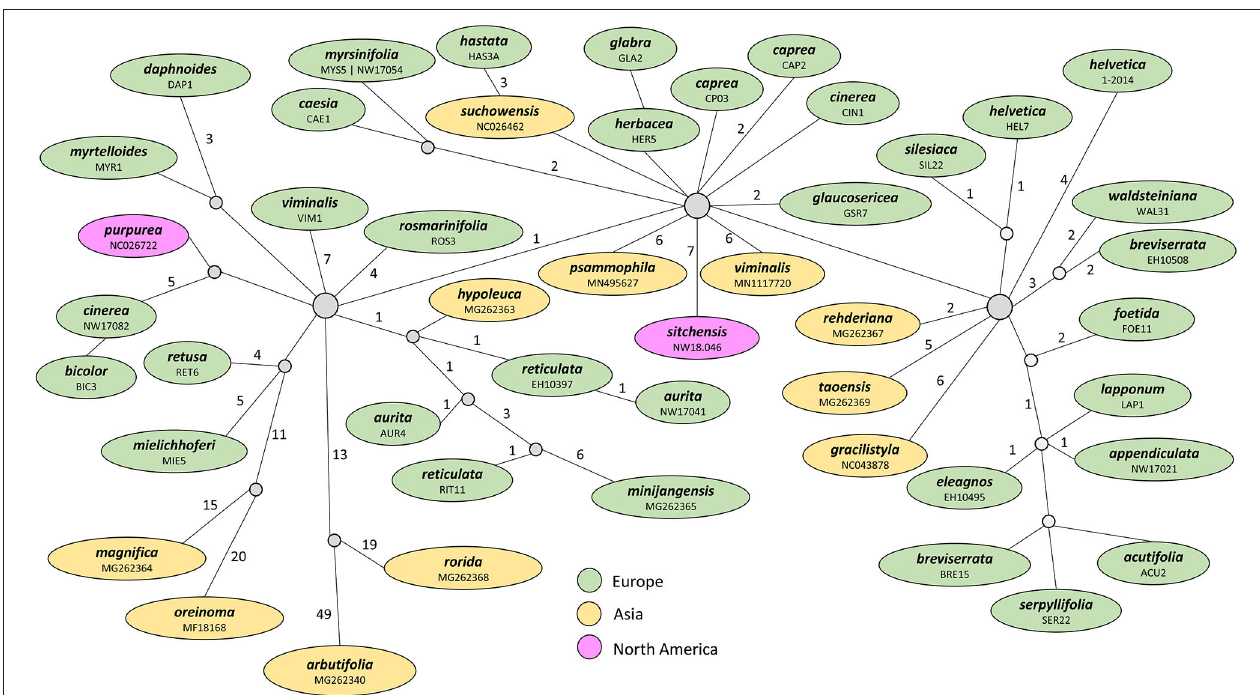
FIGURE 2 | Haplotype network of 48 samples representing 42 species of the Chamaetia/Vetrix clade based on CDS regions. Each circle represents a unique haplotype, the number of mutational steps between haplotypes are indicated by numbers above branches. The applied color-coding reflects the geographic origin of samples. Both accessions of S. myrsinifolia share an identical haplotype. The colors highlight central haplotypes and closely related groups.